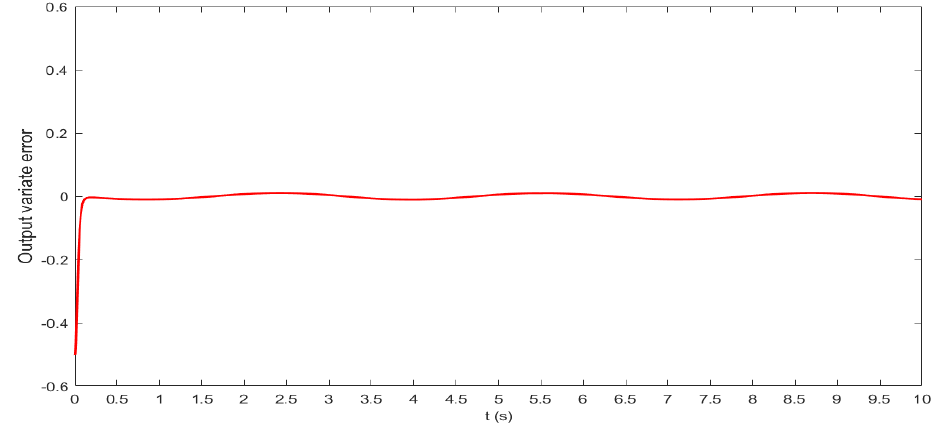
Figure 17. Output error curve.